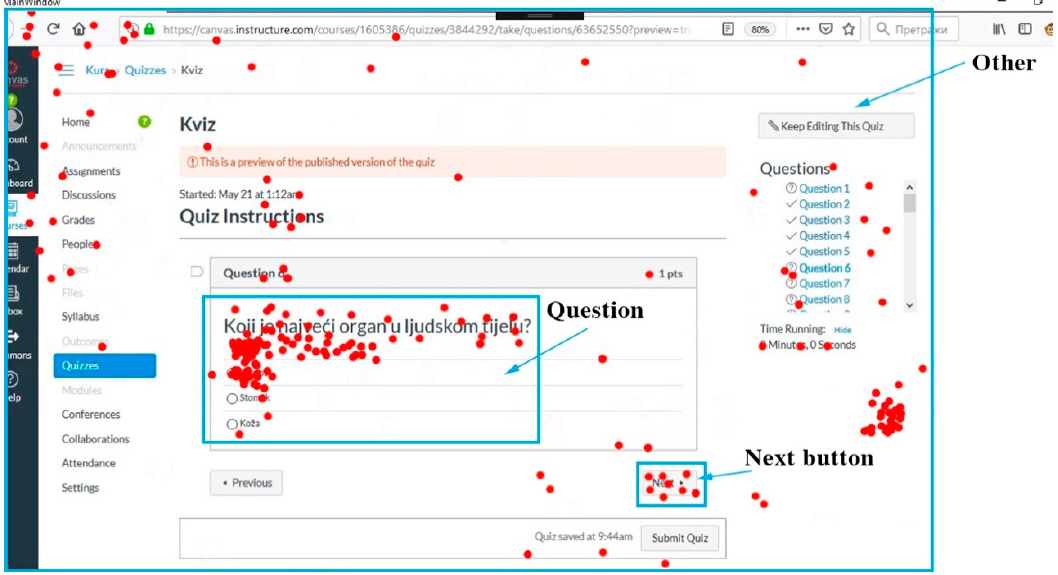
Figure 2. Areas of research (interest).